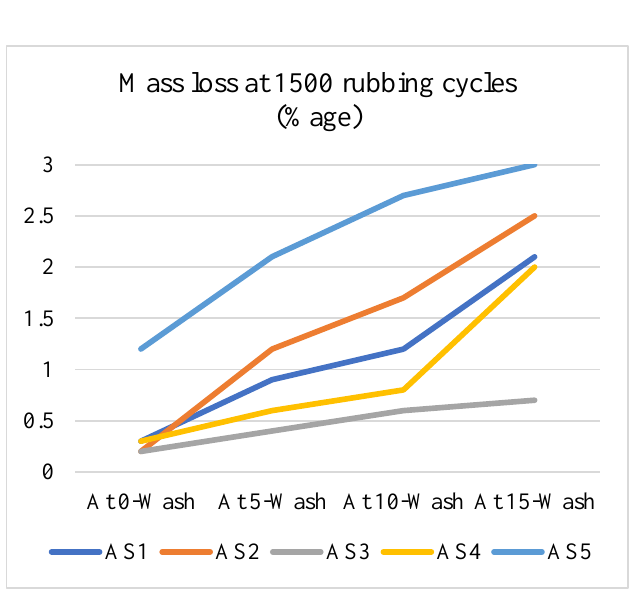
Fig. 1. Mass loss at 1500 rubbing cycles at various washing intervals